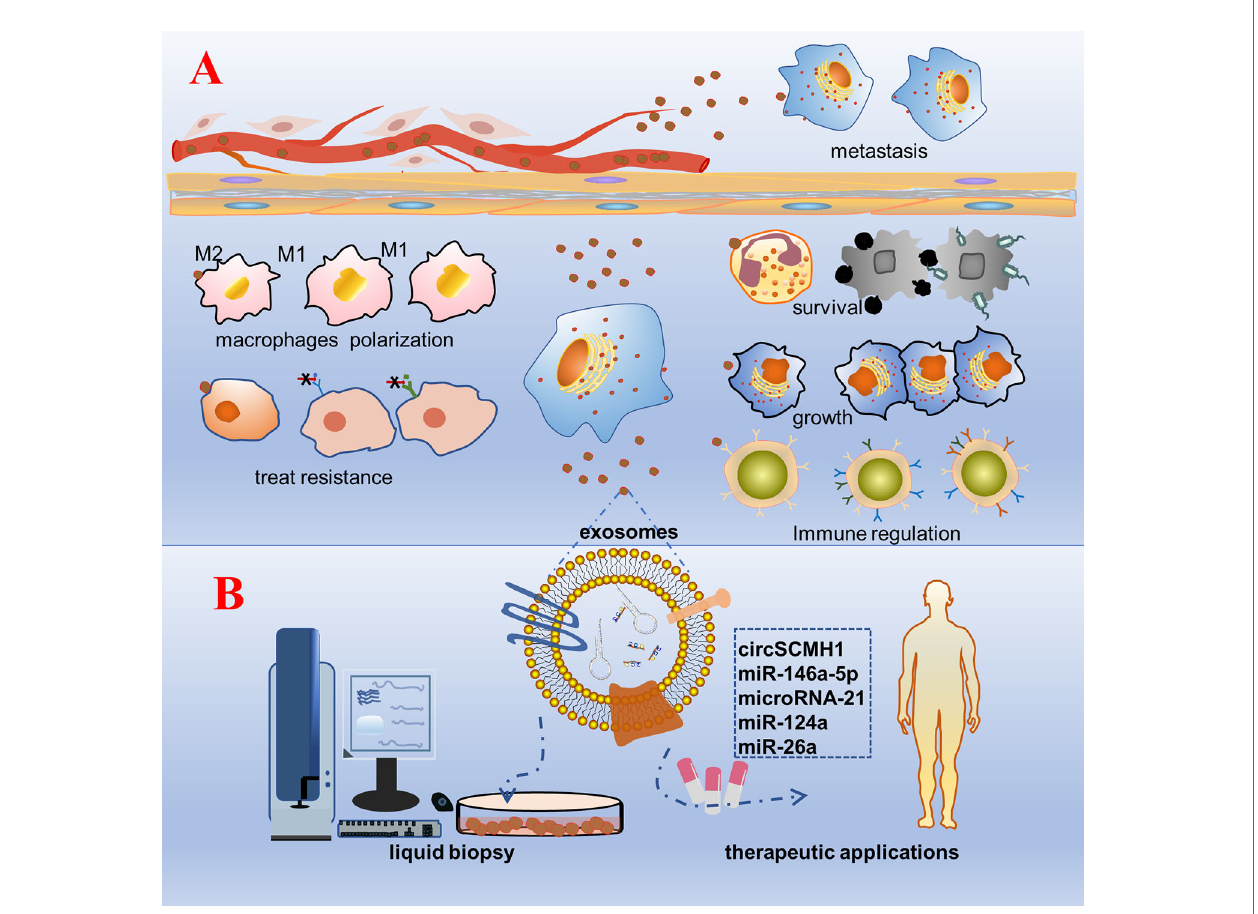
FIGURE 2 | Schematic diagram of the biological function and clinical application prospects of exosomal non-coding RNAs. (A) Biological function: cells are stimulated by factors, such as tumorigenesis, secrete exosomes wrapped with bioactive non-coding RNAs, and are accepted by the recipient cell. As a result, a series of phenotypic changes occur: pathogenic microorganisms escape the body ’ s immune surveillance to survive; growth of speci fi c recipient cells; regulation of the number and functions of immune cells, such as T cells and NK cells; polarization of macrophages and the in fl ammatory response; change in the tolerance of the recipient cells to treatment; transmission to distant tissue cells through body fl uids inducing cancer metastasis. (B) Clinical application: puri fi cation, separation, and detection of exosomes in various body fl uids, construction of a platform for rapid detection and analysis of diseases, and engineering of exosomal non-coding RNAs that are promising for